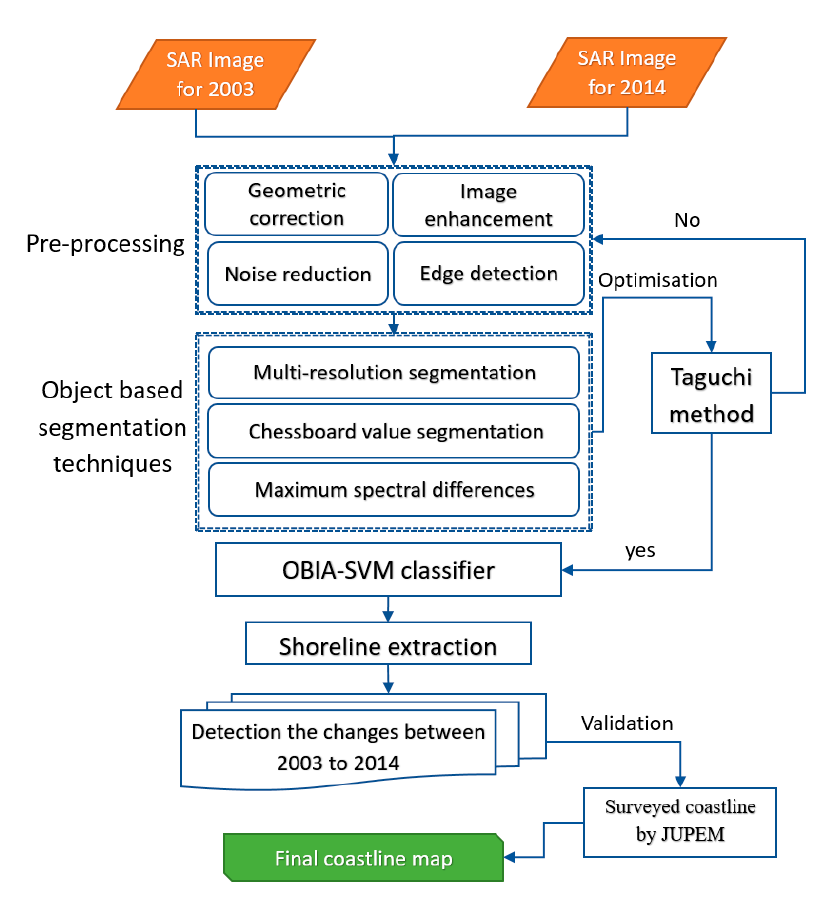
Figure 3. Computational workflow applied in this study.